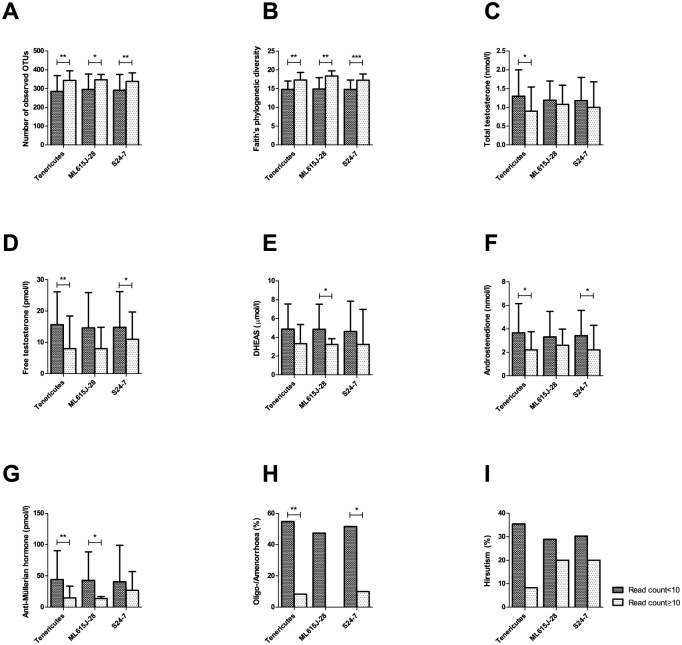
Association of differentially abundant taxa with bacterial diversity and reproductive parameters.The number of samples with detectable levels of the relevant taxa (read count ≥10) was 12/43 for Tenericutes, 5/43 for ML615J-28, and 10/43 for S24-7. Median and IQR are plotted for continuous variables.